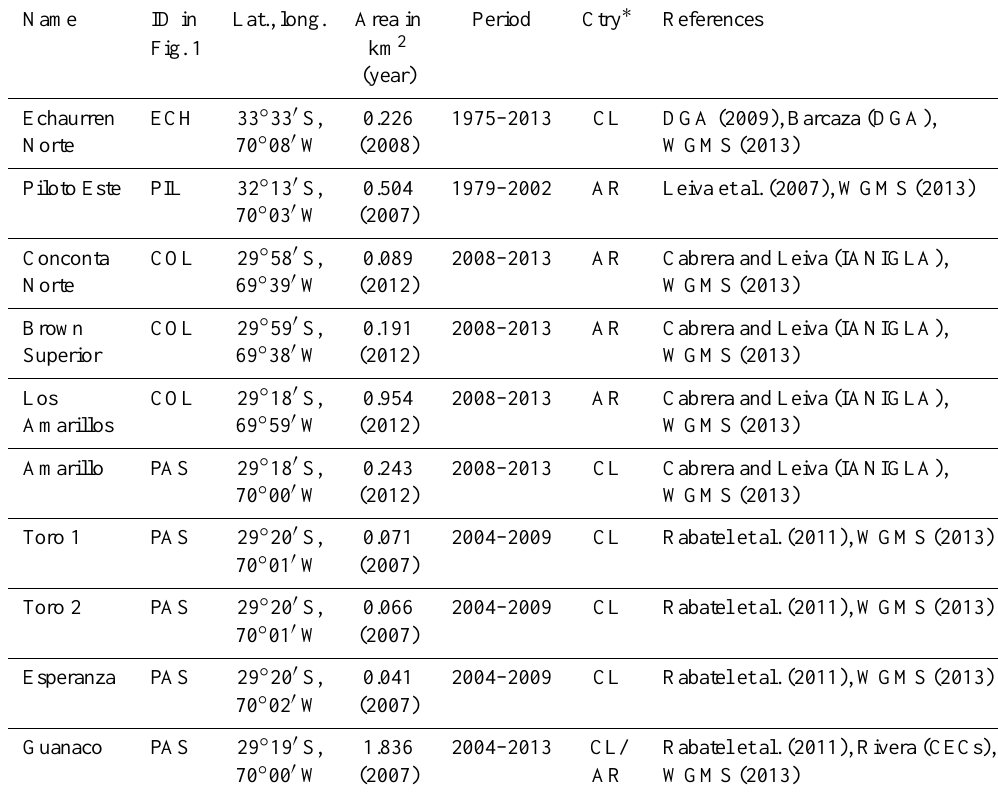
Table 1. Basic information of the glacier mass-balance series used in this study. Name ID in Lat., long. Area in Period Ctry ∗ Fig.